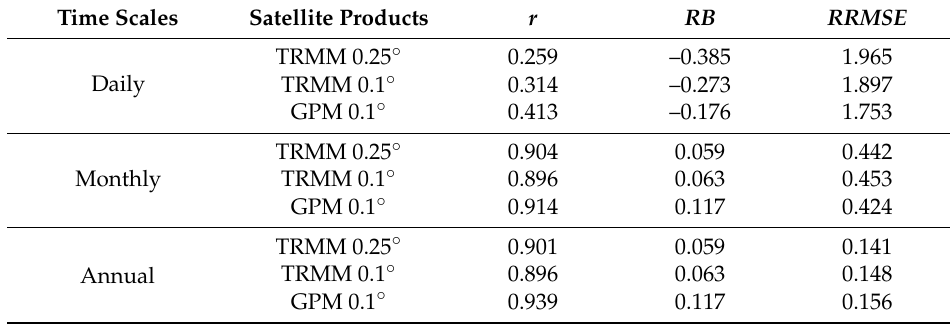
Table 2. Evaluation results of TRMM 0.25 ◦ , TRMM 0.1 ◦ , and GPM 0.1 ◦ precipitation estimates at multiple timescales from 2015 to 2017 over the Hauihe River